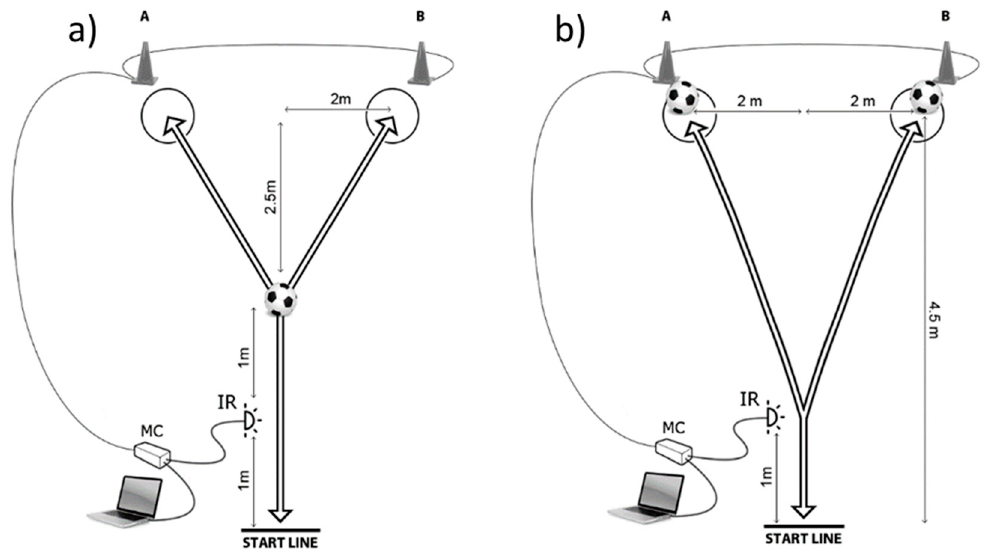
Figure 1. Testing of the futsal specific change of direction speed and reactive agility including ( a ) dribbling and ( b ) ball touching (MC—microcontroler, IR—infrared beam). ( a ) dribbling and ( b ) ball touching (MC—microcontroler, IR—infrared